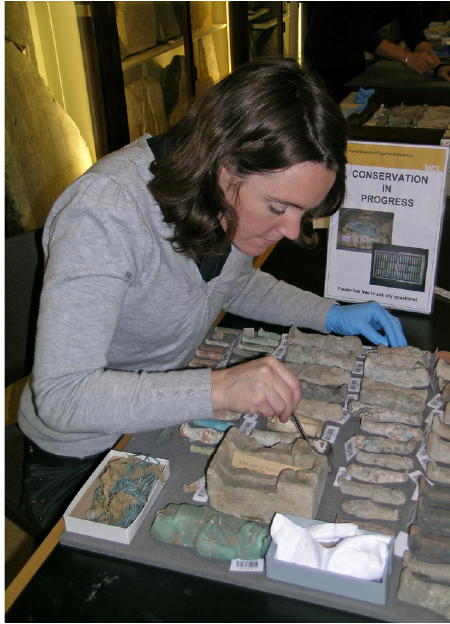
Fig. 5: Gemma Aboe, conservation intern, at work on some of the Petrie Museum’s shab- tis ; her 18-month internship was funded by the Friends of the Petrie Museum and the British